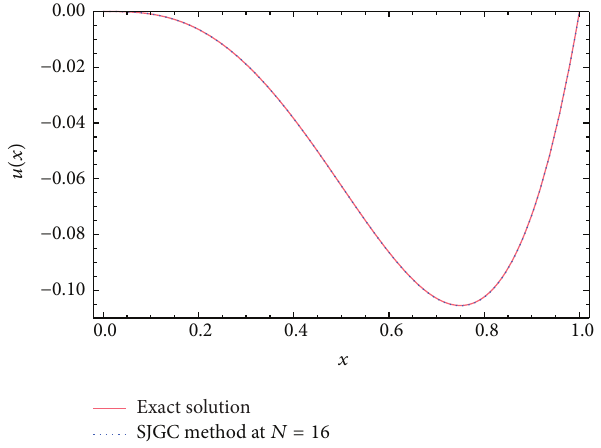
Figure 1: Graph of exact solution and approximate solution for ] = 1/2, 𝜇 = −1/2 at 𝑁 = 16 for Example 3.